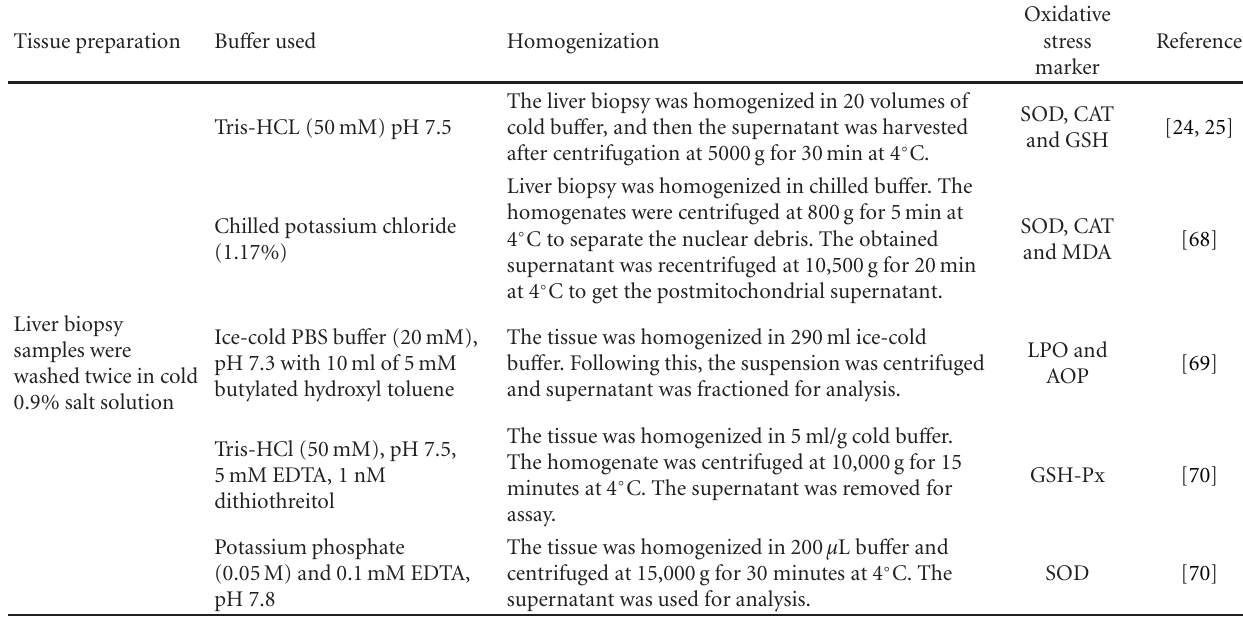
Table 1: Methods for preparation of liver biopsy implemented in di ff erent studies. Tissue